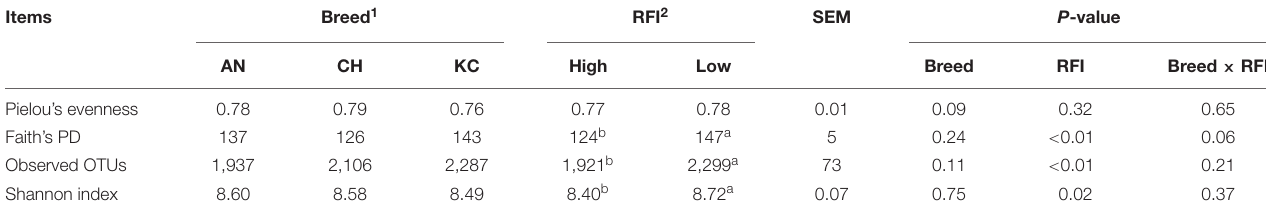
TABLE 1 | Effects of breed and RFI on the alpha diversity indices of rumen eukaryotic communities. Items